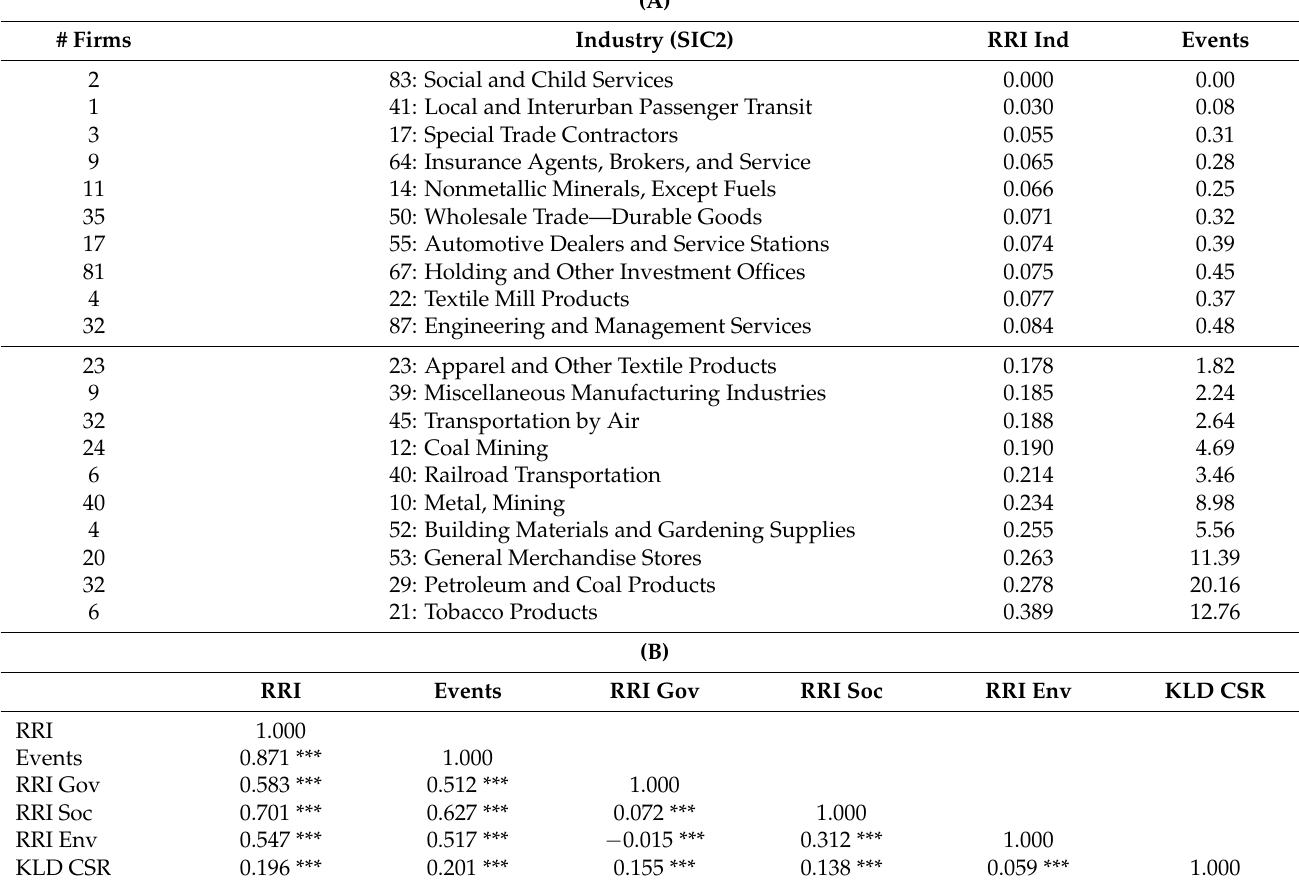
Table 2. ( A ) Average RRI by industry. This table sorts industries by how firms’ exposure to negative media coverage. RRI Ind is the average RRI for each firm by industry. Events is the average annual number of events per firm in each industry. ( B ) Correlation matrix—RRI and CSR measure. The table below shows the correlation coefficients between the various measures of reputational risk (RRI, Events, RRI Gov, RRI Soc and RRI Env) and CSR investment (KLD CSR). See Appendix A for variable definitions. *, ** and *** represent statistical significance at the 10%, 5% and 1% level, respectively.